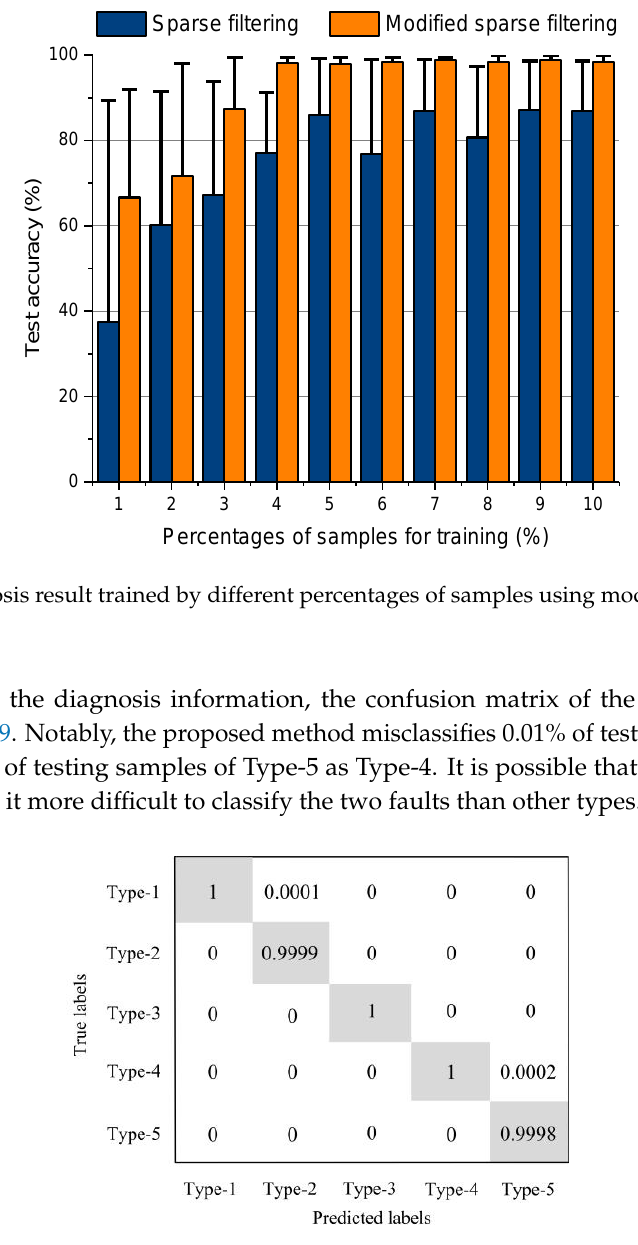
Figure 17. Diagnosis result using various input dimensions of modified and original sparse filtering.